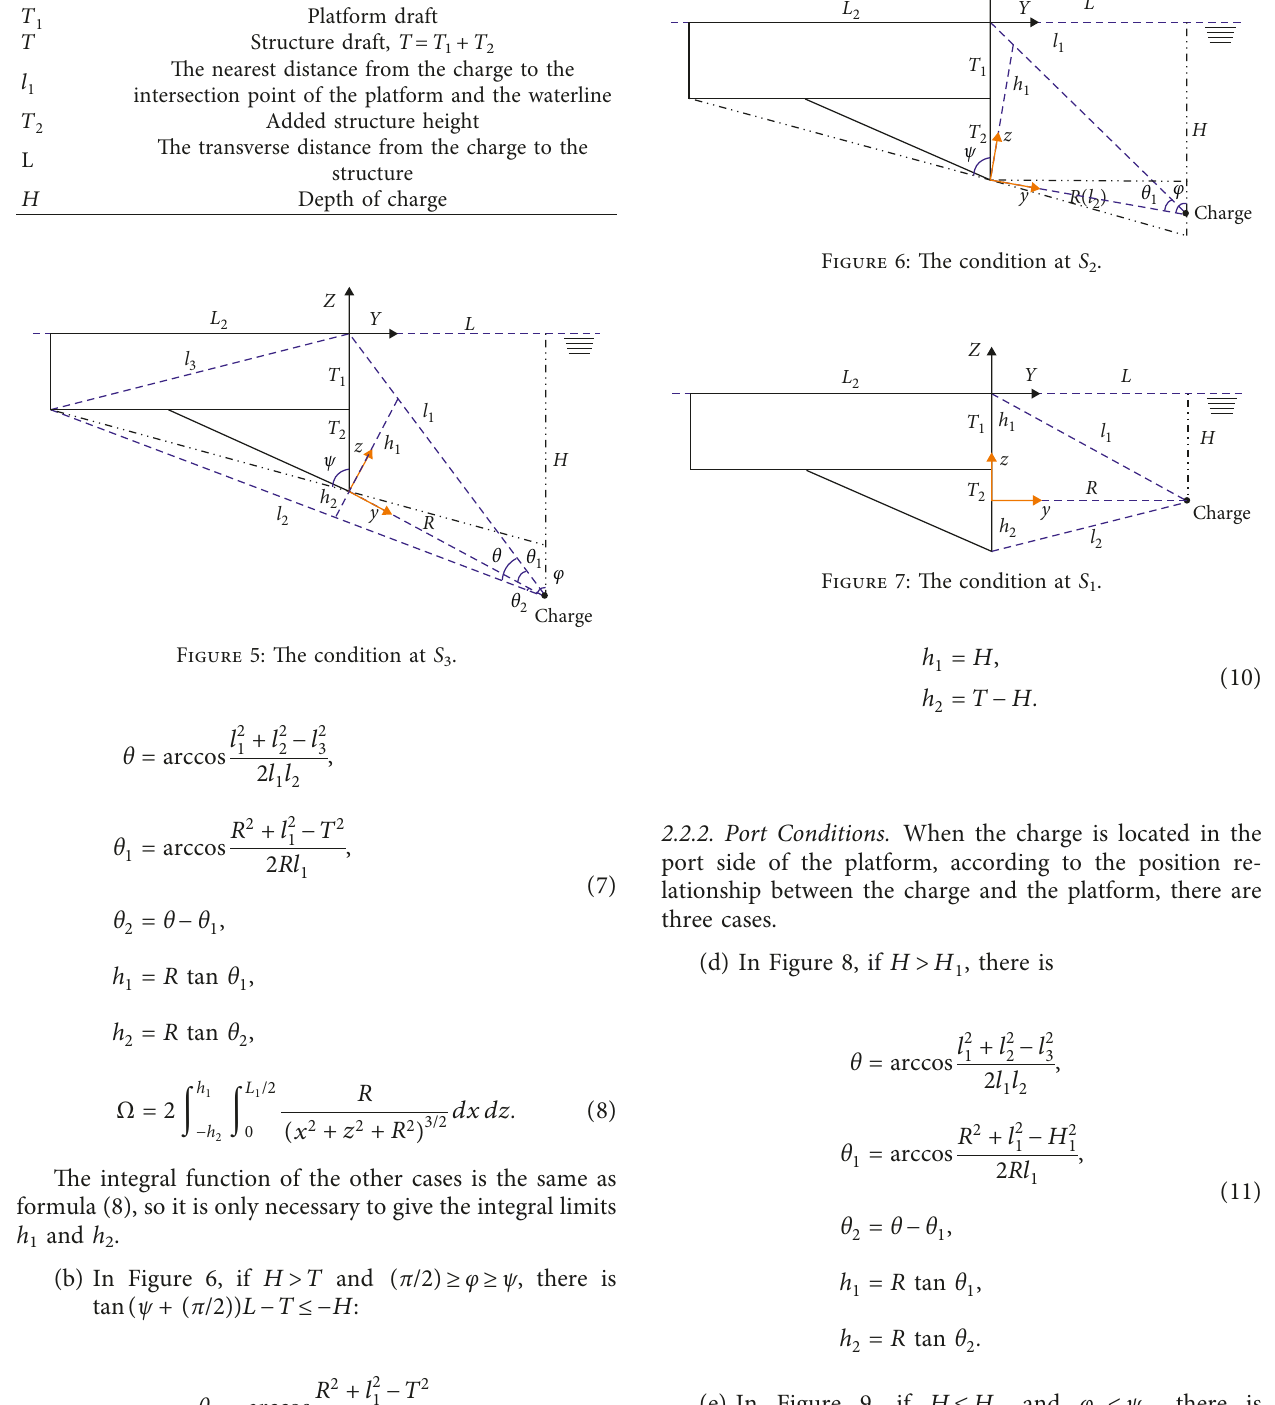
Table 1: Geometric parameters definition.